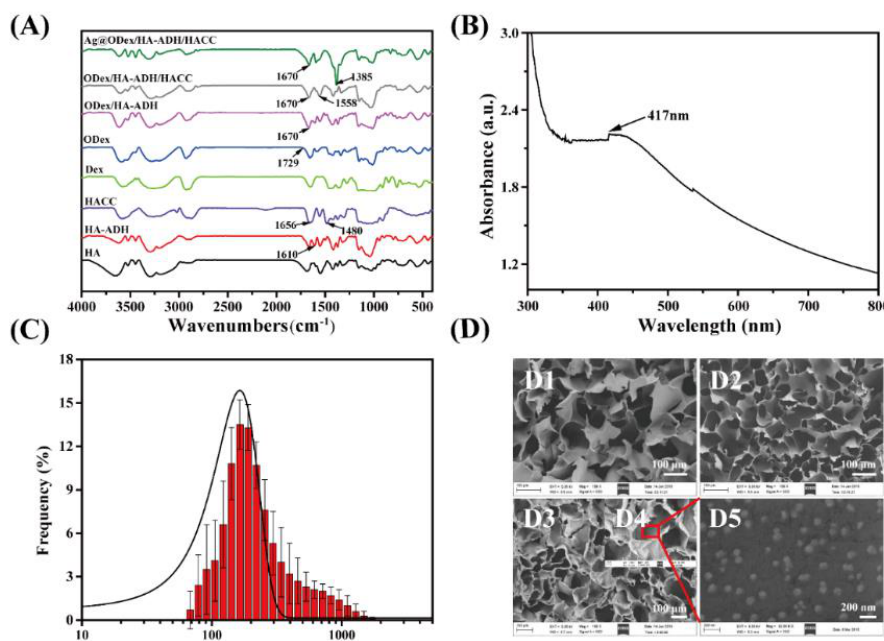
Figure 1. Characterization of the ODex/HA-ADH, ODex/HA-ADH/HACC and Ag@ODex/HA- ADH/HACC hydrogels. ( A ) FTIR spectra of different components. ( B ) UV–vis spectra of silver nanoparticle. ( C ) The size distribution of silver nanoparticles measured using DLS. ( D ) SEM images of different hydrogels: D1: ODex/HA-ADH hydrogel; D2: ODex/HA-ADH/HACC hydrogel; D3: Ag@ODex/HA-ADH/HACC hydrogel; D4 and D5 are partially enlarged images of D3.